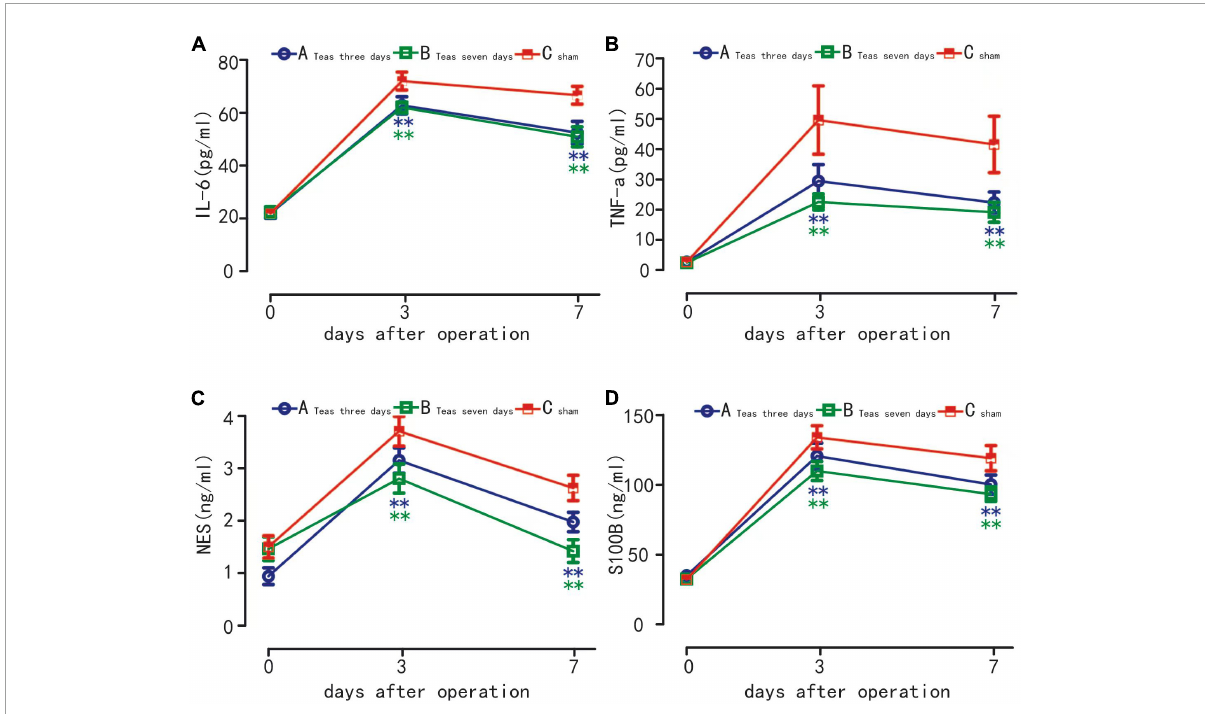
FIGURE4 Plasma levels of IL-6 (A) TNF- α (B) S100 β (C) and NSE (D) in three groups. ∗∗ P < 0.01 vs. group A at the same time point; ∗∗ P < 0.01 vs. group B at the same time